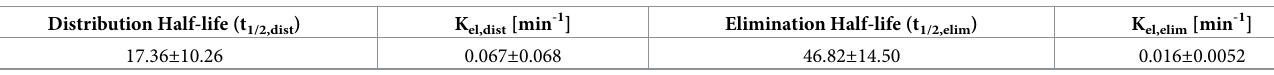
Table 1. Pharmacokinetics of FA-Gd in ApoE -/- mice determined by MRI. Distribution Half-life (t 1/2,dist